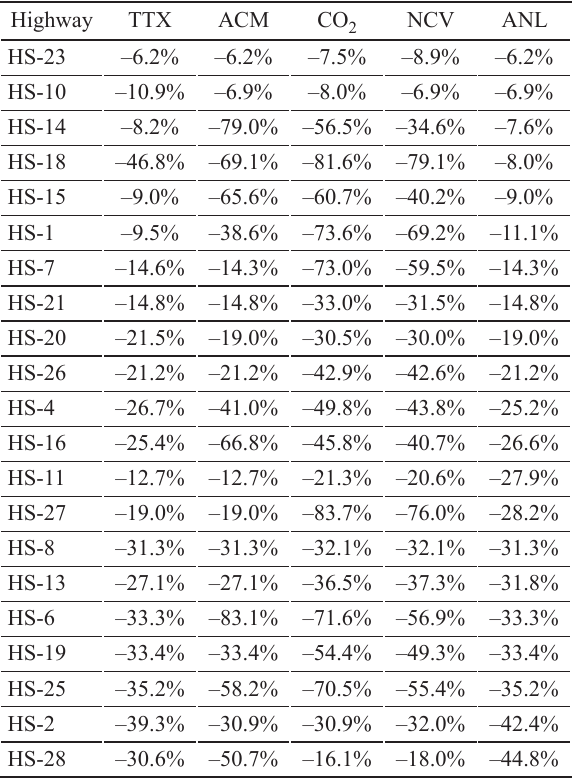
Table 5. Target reductions in input variables (%) Highway TTX